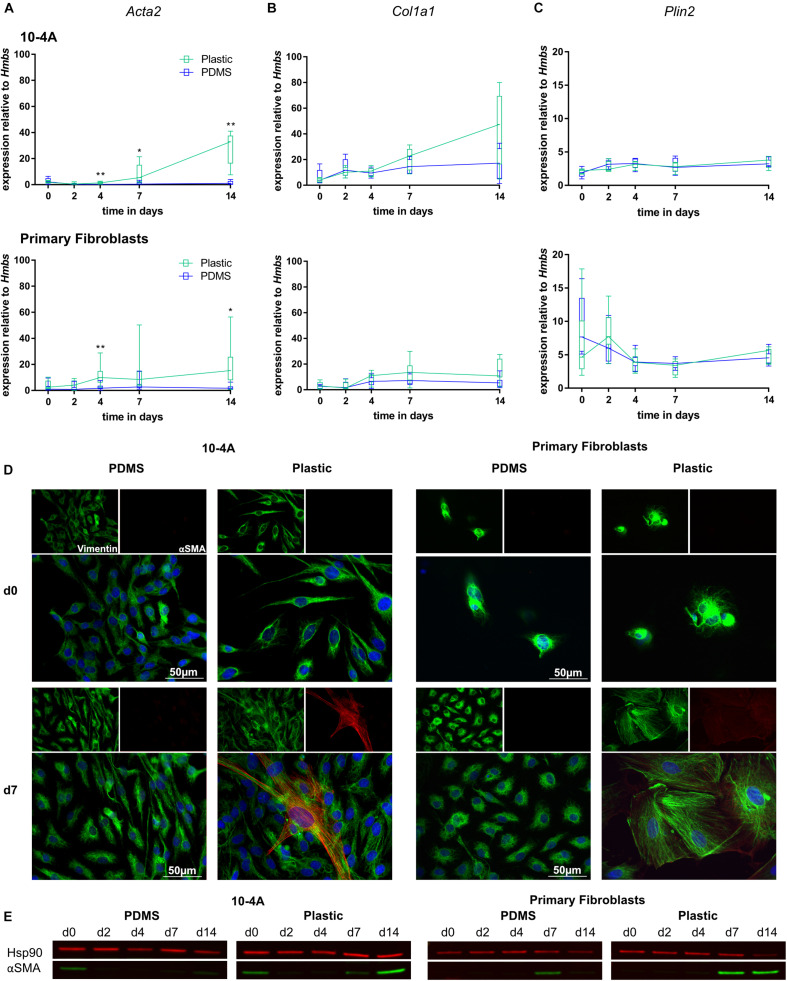
Mechanical stimulation of 10-4A cells and primary fibroblasts. Semi-quantitative RT-PCR analysis of Acta2
(A), Col1a1
(B), and Plin2
(C) expression in 10-4A cells (top graph) and primary fibroblasts (bottom graph) maintained on soft PDMS or stiff plastic substrate, respectively. Data are expressed as fold expression of the housekeeping gene hydroxymethylbilane synthase (Hmbs). Primary fibroblast data were obtained from seven different animals, 10-4A data from five different passages. Statistical significance for the respective time points was tested with the non-parametric Mann–Whitney-U-Test. Statistical significance is indicated as follows: p-values < 0.05: *, p-values < 0.01: **. Box plots show data as median values, the boxes represent percentiles, the whiskers indicate the minimum/maximum. (D) Immunofluorescence staining of 10-4A cells (left) or primary fibroblasts either seeded on PDMS or plastic directly after adherence (d0) or 7 days post-seeding. Cells were stained for the mesenchymal marker vimentin (green) and the pro-fibrotic protein αSMA (red). Scale bar = 50 μm. (E) Western Blot for αSMA in 10-4A cells and primary fibroblasts cultured over 14 days on soft (PDMS) and stiff (Plastic) matrices, respectively. HSP90 was used as loading control.